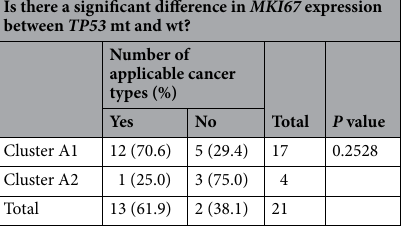
Table 3. Comparison of the number of cancer types with a significant difference in MKI67 expression by TP53 genotype between cluster A1 and